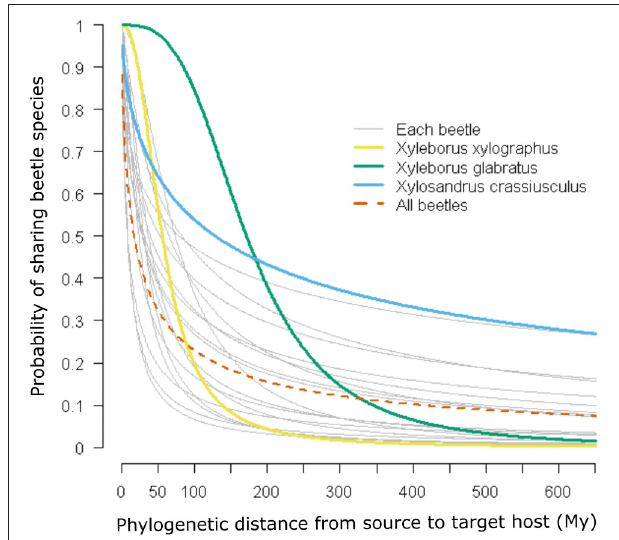
coefficients given in Table 1 . Four relationships are highlighted: a narrow host range and phylogenetically constrained species ( Xyleborus xylographus ), a wide host range and phylogenetically constrained species ( Xyleborus glabratus ), a wide host range and phylogenetically dispersed species ( Xylosandrus crassiusculus ), and all beetle species